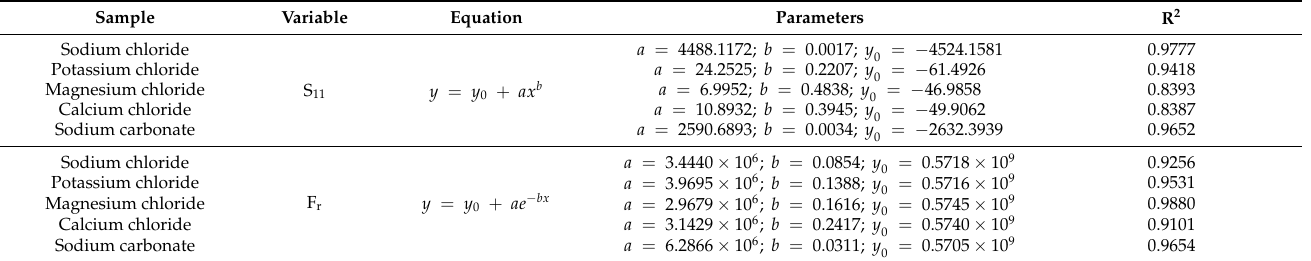
Table 2. The equations and parameters of this relationship for each salt in the frequency range of the first resonance peak.